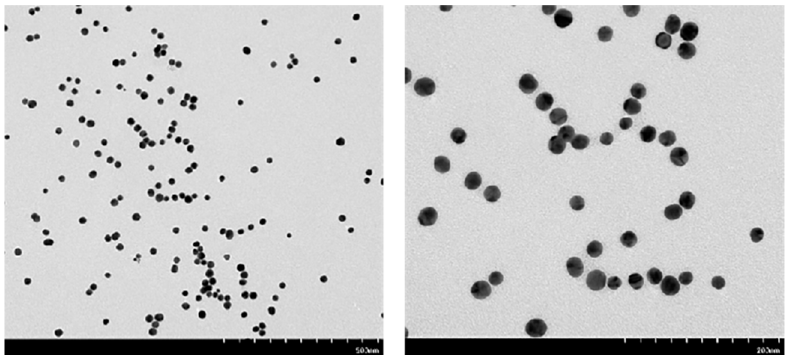
Figure 9. Transmission electron microscopy image of the spherical gold nanoparticles.